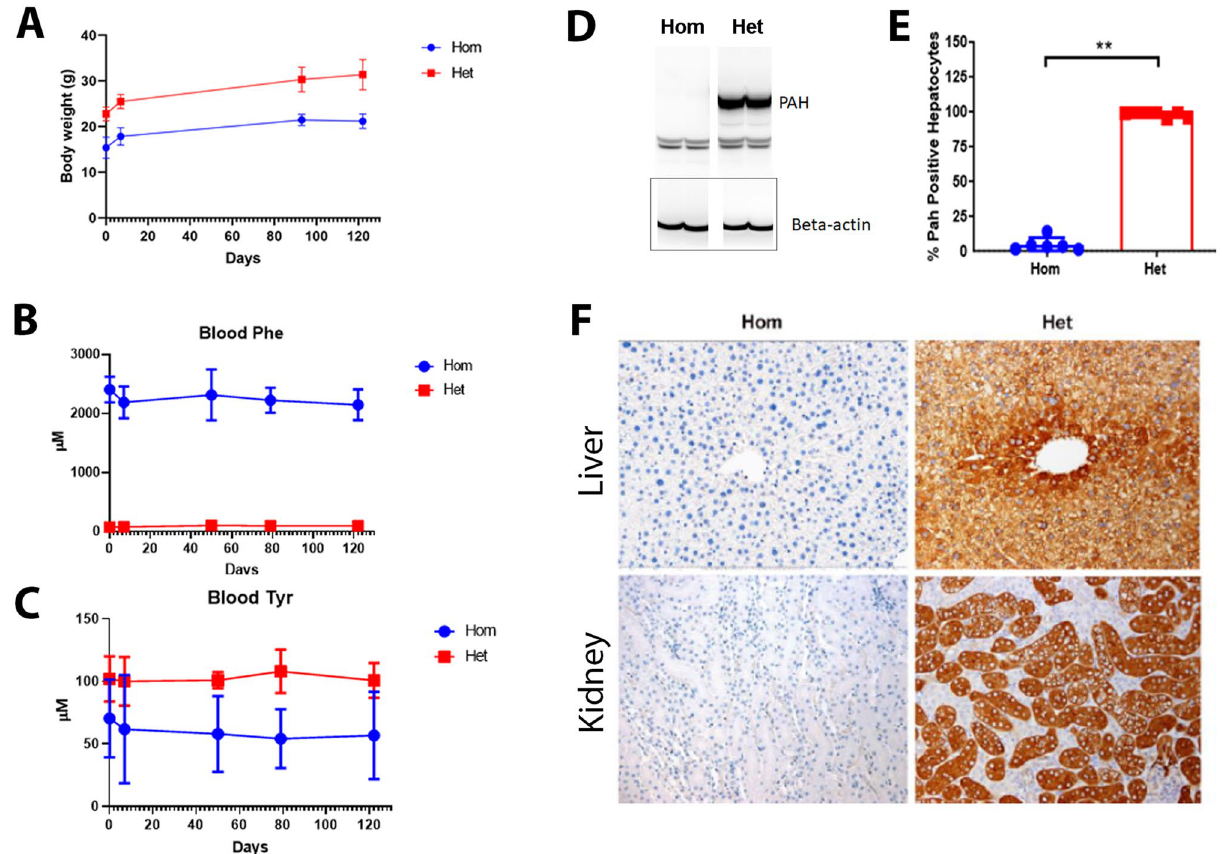
Figure 2. Characterization of Hom and Het Pah -KO mice for 6 months. ( A ) The Hom mice showed lower bodyweights than the Het mice throughout the study ( B ) Summary of blood Phe at various timepoints is shown (n = 7/group) ( C ) Summary of blood Tyr at various timepoints is shown (n = 7/group). The graphical data are represented as mean ± SD (Phe and Tyr levels in Hom vs Het mice p < 0.0001) (n = 7 mice/group). ( D ) Western blot analysis of liver homogenate using anti-PAH antibody is shown. Note the lack of PAH protein in the Hom mice whereas Het mice showed a corresponding band (~ 50 kDa) for mouse PAH protein. Each lane contained 135 µg protein. Beta actin was used as an internal control. Full-length blots/gels are presented in Supplementary Fig. 2. ( E ) Summary of % PAH positive hepatocytes in the Hom and Het mice are shown. The graphical data are represented as mean ± SD (** p = 0.0012). ( F ) Representative liver and kidney PAH-IHC images show lack of IHC signal in a Hom mouse whereas liver from a Het mouse exhibit strong IHC signal in hepatocytes, mostly in the centrilobular region. Renal cortical epithelial cells from a Hom mouse show no IHC signal as compared to Het mouse, where most proximal convoluted tubular epithelium exhibit strong